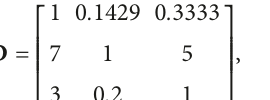
Table 6: Assignments of PF, PSIs, and PCIs of shared parking lots. Communities